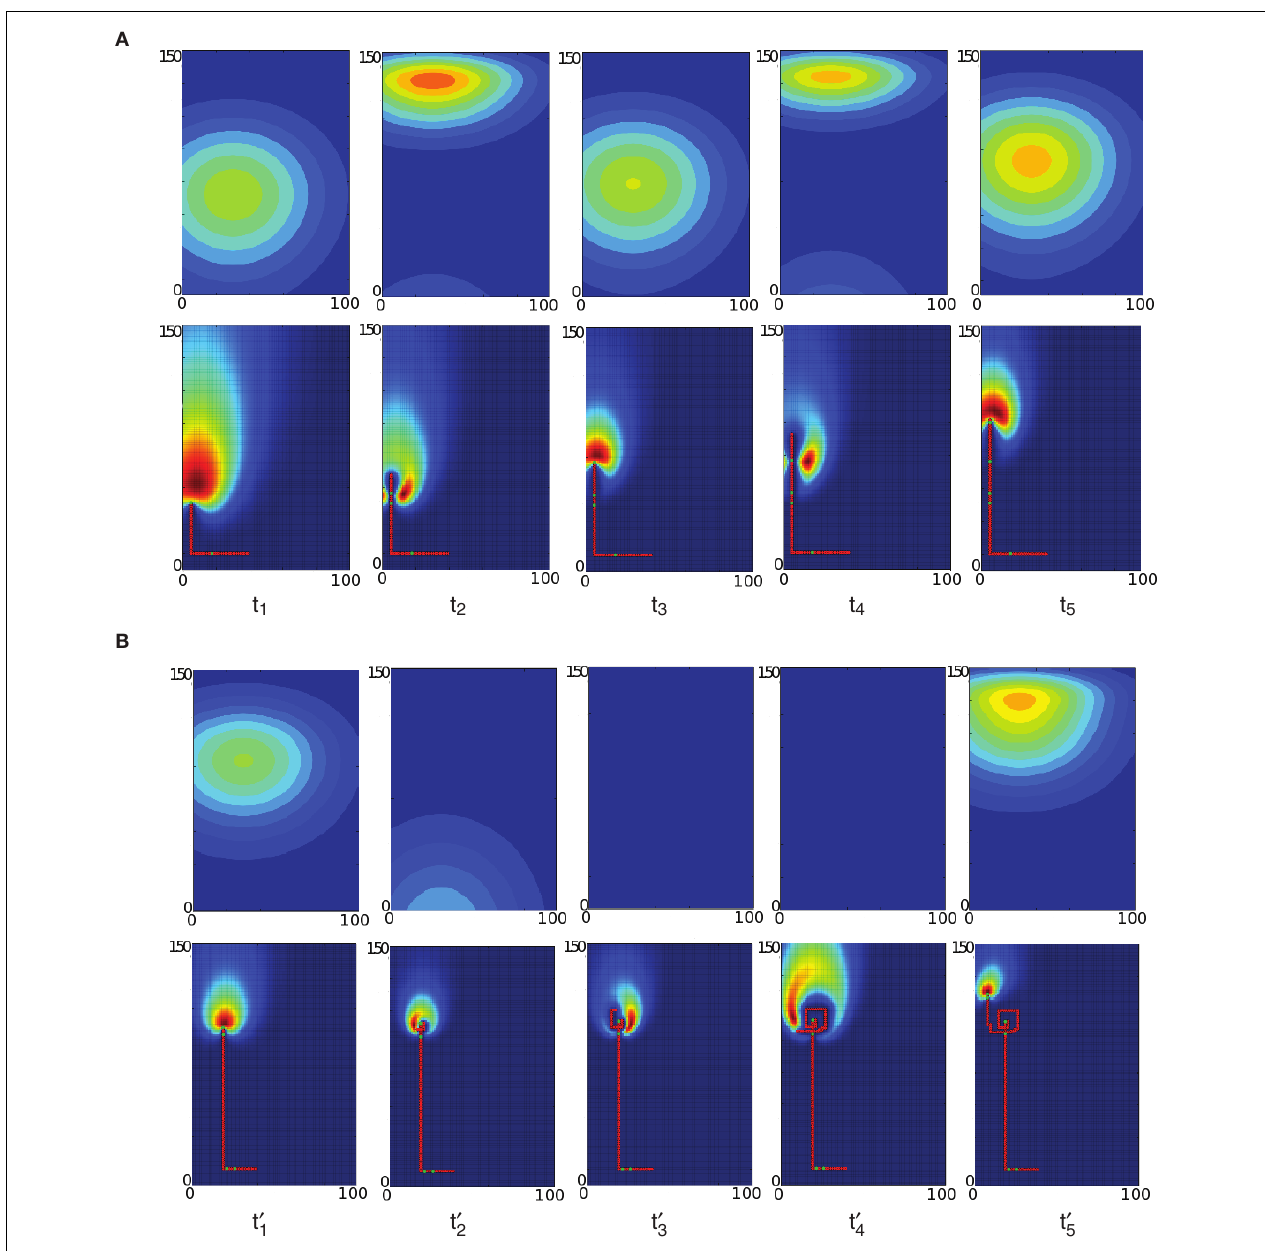
FIGURE 5 | Navigation patterns observed when infotaxis is confronted to a pulsed source (fast pulses in A, slow pulses in B). Top rows represent snapshots of the simulated environment at different times [pulsed source located in r = (25, 2), wind blows downwards] and bottom rows are for the 0 corresponding source distribution (belief function). False blue and red colors correspond to low and high probabilities, respectively. The path of the robot is superimposed to the map as consecutive red dots when there is no detection, and green dots for detections. (A) High-frequency pulsed patches provoke new detections before the robot starts spiraling. High probabilities are frequently